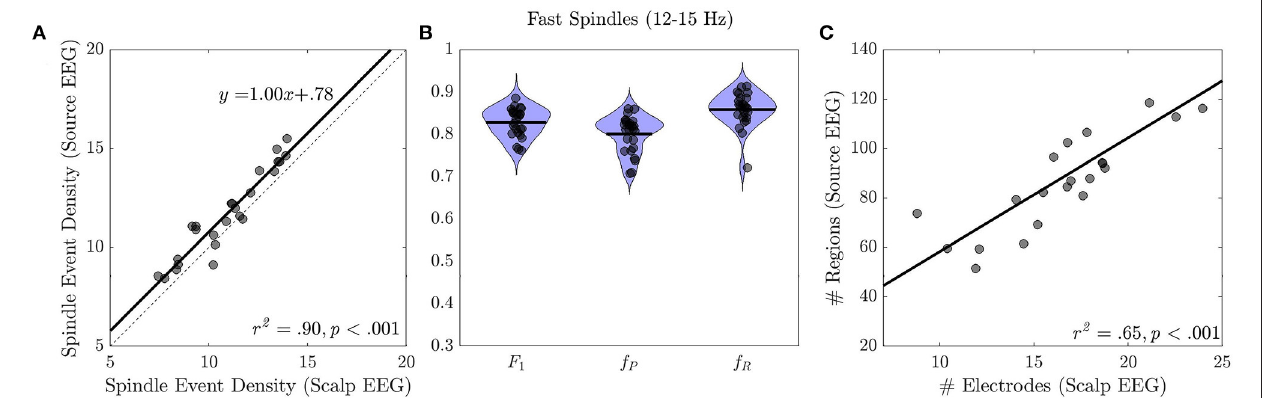
FIGURE 3 | Spindle events in source vs. sensor space EEG. (A) Spindle event density in source vs. sensor space. Regression line (black solid) and the identity line (gray dashed) are shown. (B) Correspondence of spindle events detected at the source vs. the sensor space (F1 = 0.83 ± 0.03, fP = 0.80 ± 0.04, fR = 0.86 ± 0.04). (C) Spatial extent of spindle events in source vs. sensor space with regression line. regression models with subject as a random effect. To